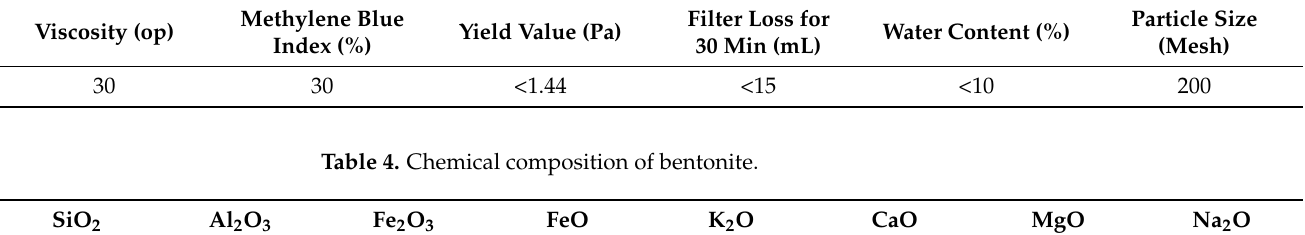
Table 3. Physical performance of bentonite.